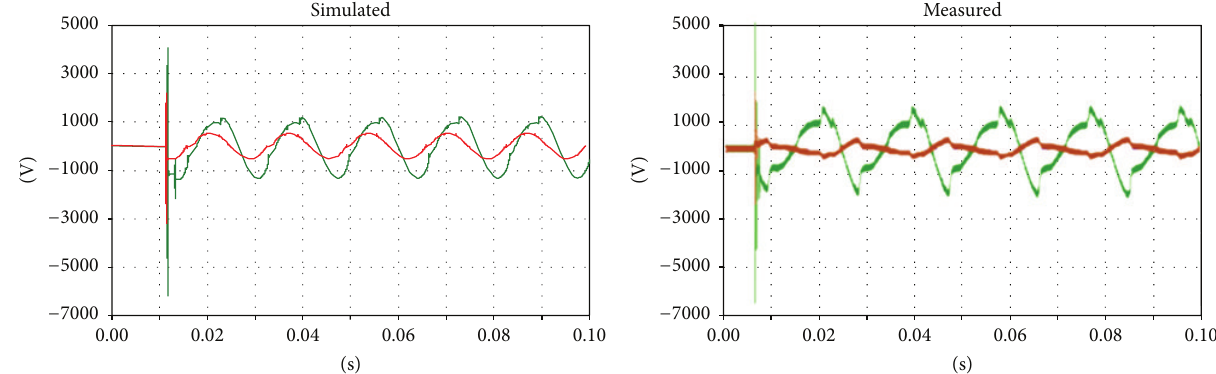
Figure 11: Voltage on the secondary side of the transformer; green: main coil, red: tap